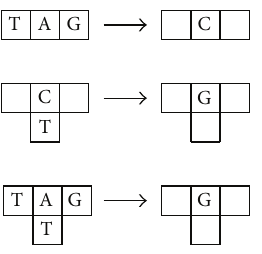
Figure 1: A simple example of the new T-DNA CA.